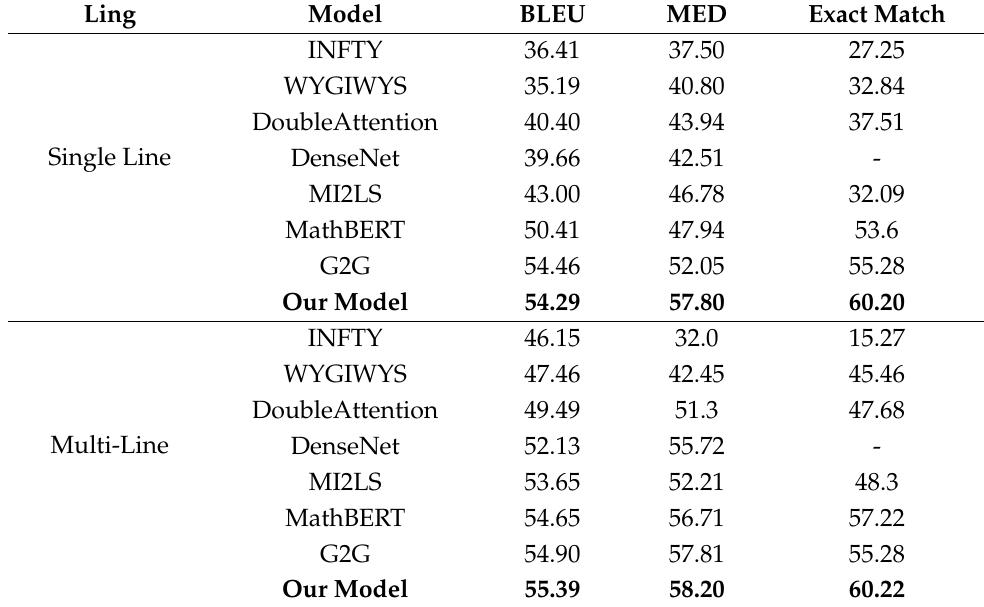
Table 3. The effect of our model on the handwritten formula dataset. It can be seen from the table that our model is better than other similar models.